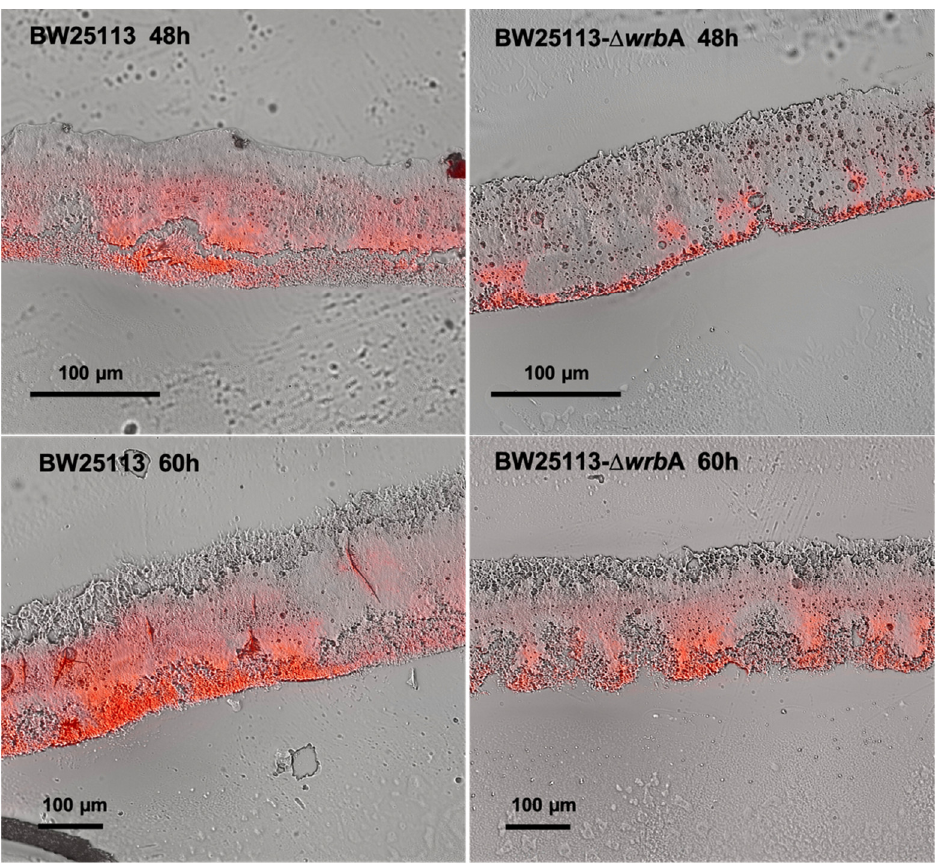
Figure 2. Images of cryosectioned BW25113 (first column) and BW25113-∆ wrb A (second column) biofilms collected at 48 and 60 h. The images were obtained by overlapping the view acquired in bright field (the whole biofilms) and epifluorescence (the EPM stained with Texas Red-labeled Concanavalin A) modes.